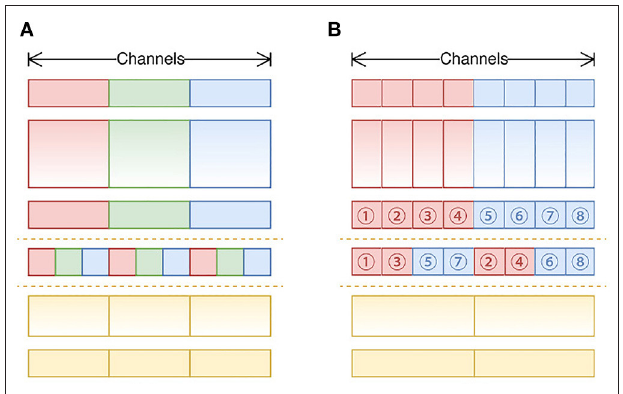
FIGURE 7 | (A) The standard channel shuffle operation in ShuffleNet; (B) channel reorganization operation in our study.